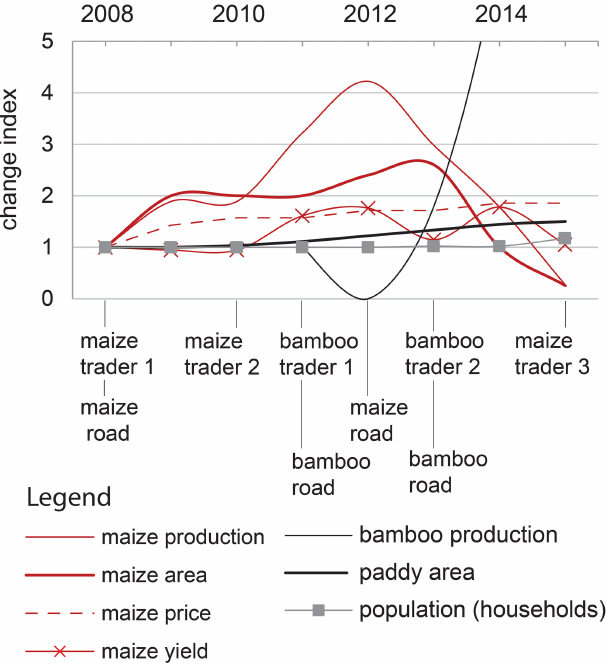
Fig. 3 . History of hybrid maize cropping in Phoun-neua village. For comparability of different units, the changes of agro- economic parameters are shown as a change index relative to the start of hybrid maize cropping in